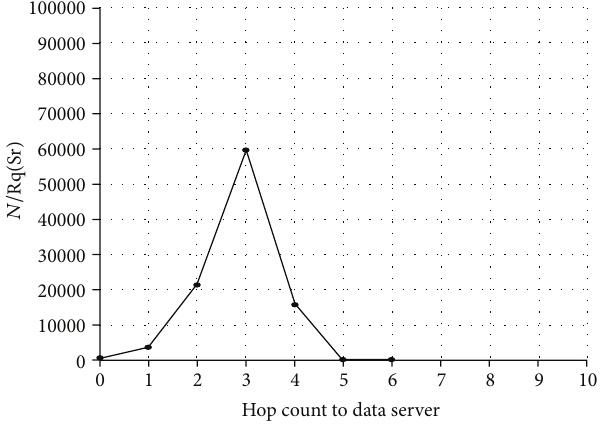
Figure 8: Static adjacent list size (6) .